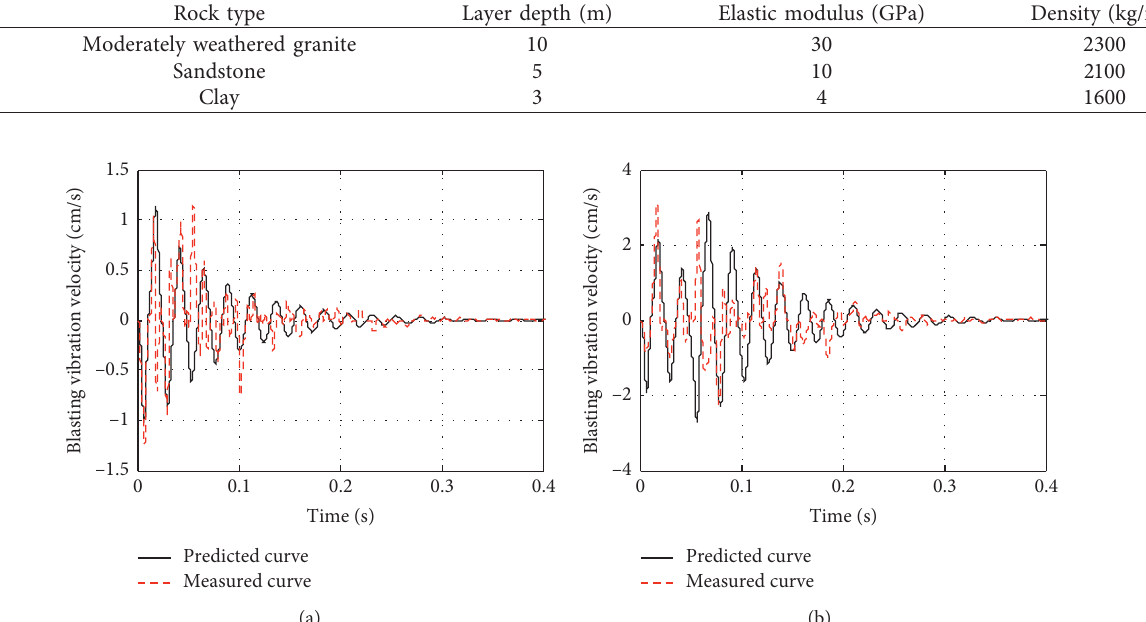
Figure 7: Comparison of time-history curves of predicted and measured blasting vibration velocity. (a) Test 1. (b) Test 2.